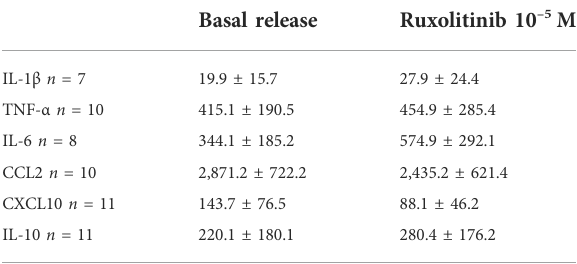
TABLE 1 Amounts of cytokines in the supernatants of non-stimulated human LMs treated for 24 h with vehicle (basal release) or 10 – 5 M